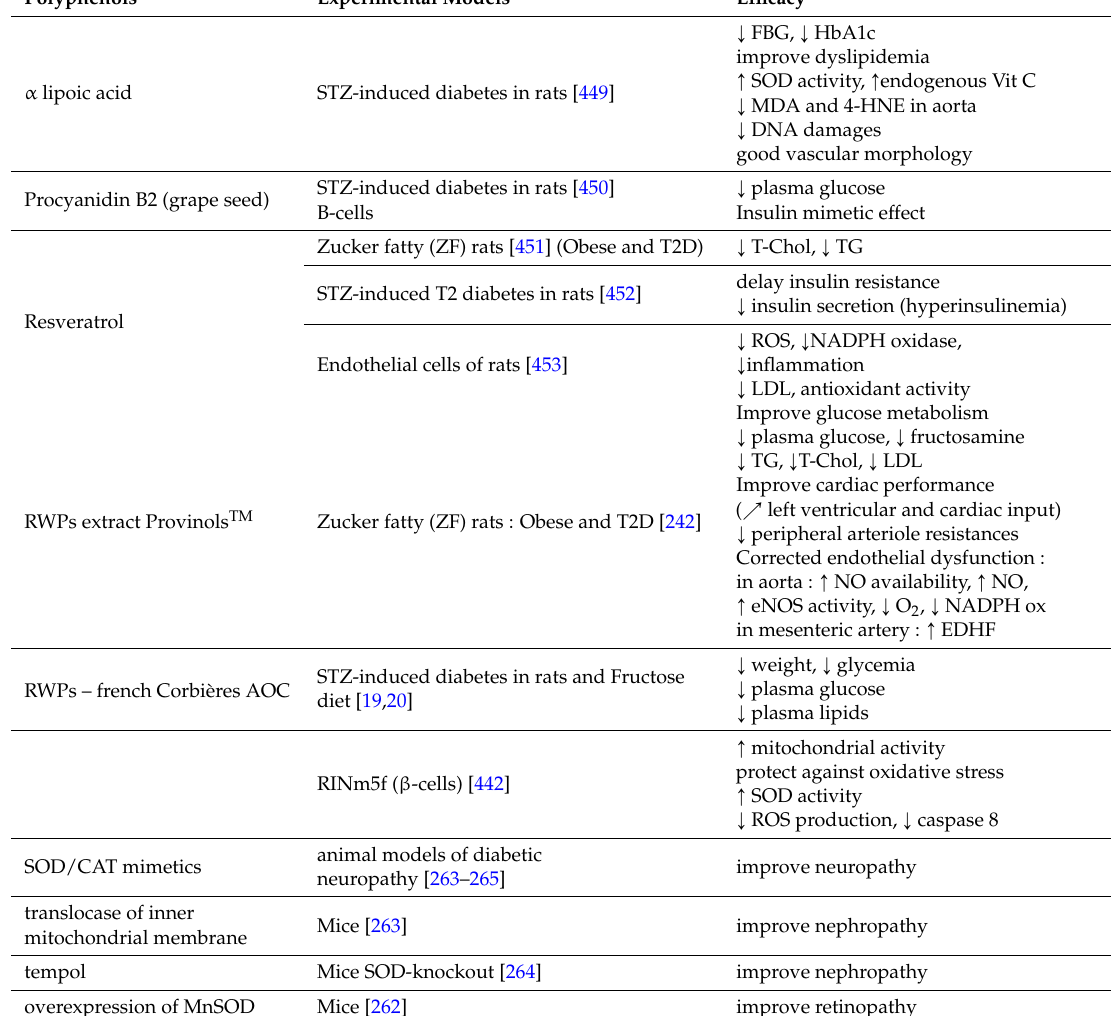
Table 7. Beneficial effects of several polyphenol-rich natural sources on in vitro and in vivo models of